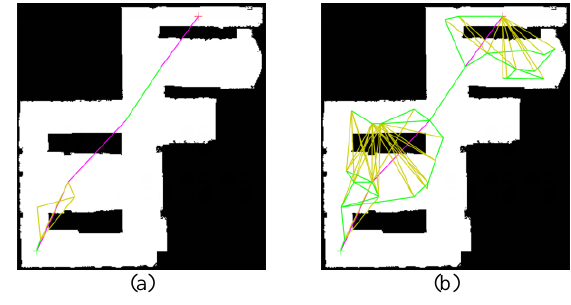
Figure 3 . Path sections before (a) and after (b) update.